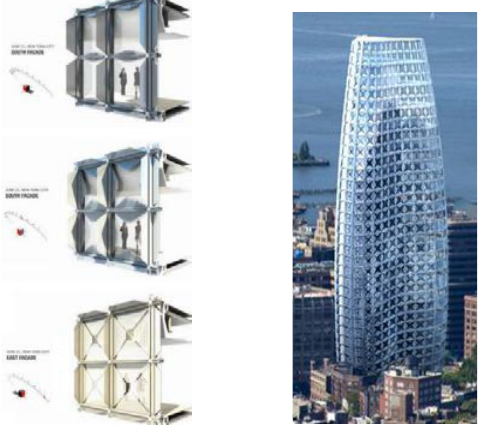
Figure 17. Showroom Dynamic façade system with unlimited faces, (El-Semary,